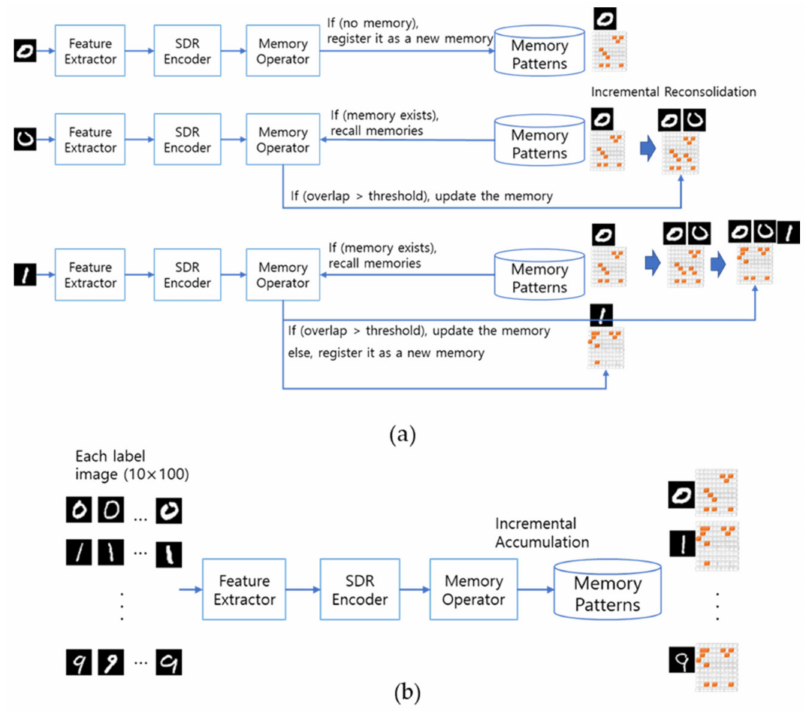
Figure 14. Experiment overview: ( a ) Procedures for generating progressive memories, ( b ) The process of creating a